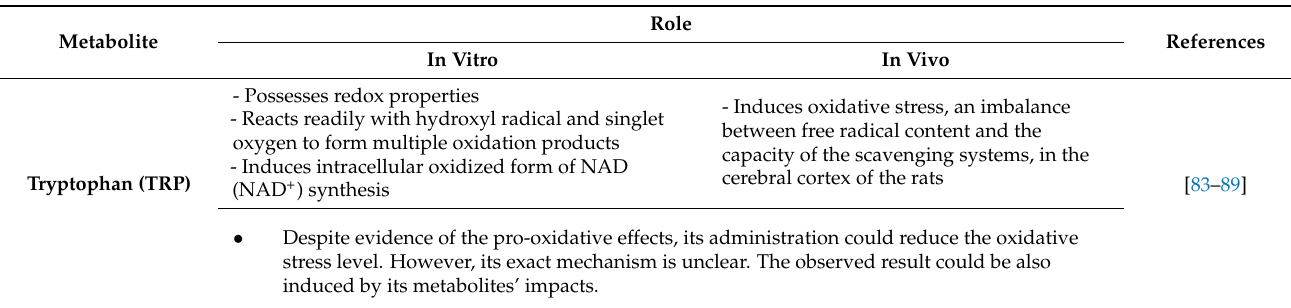
Table 1. Impact of kynurenine pathway metabolites on oxidative stress during the development of neurodegenerative processes.